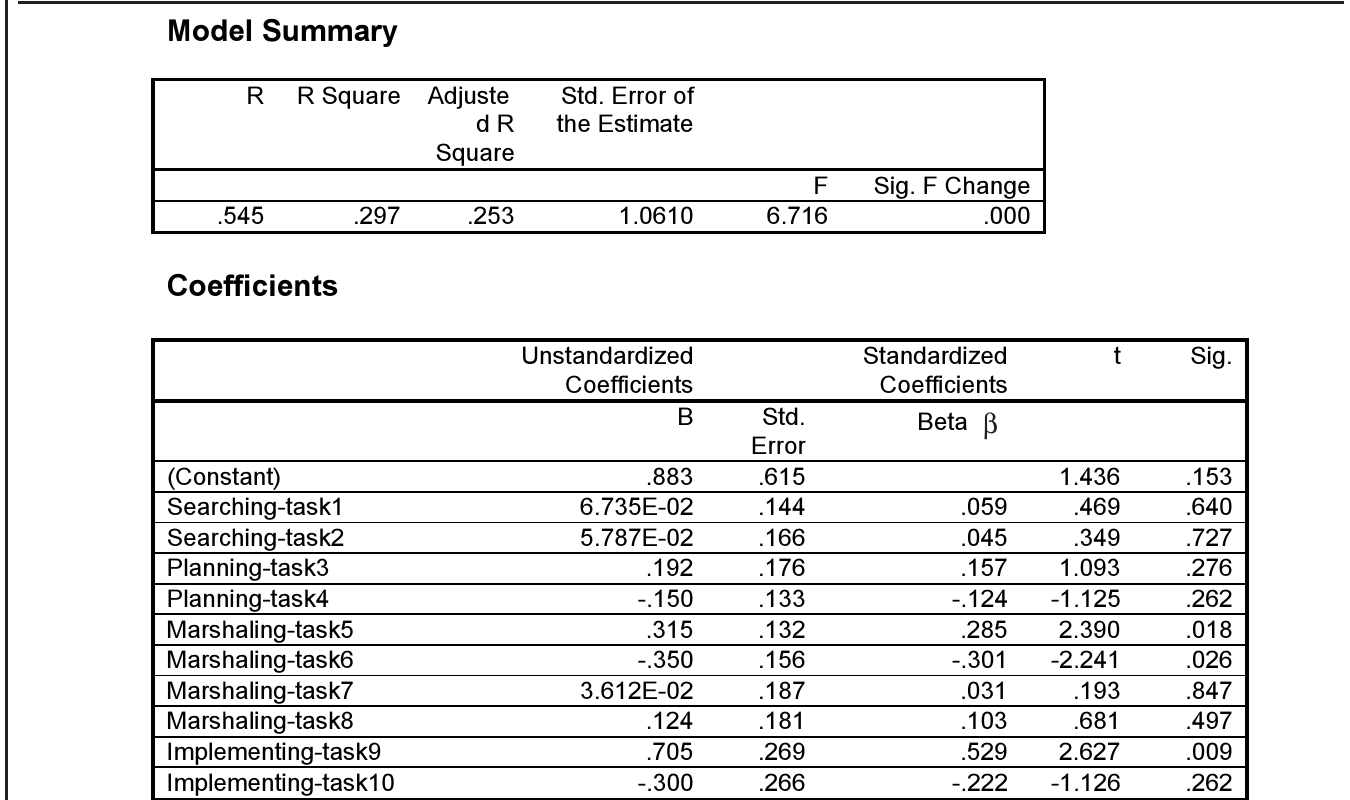
Table 3. Influence on Four Phases and Corresponding Tasks on Entrepreneurial